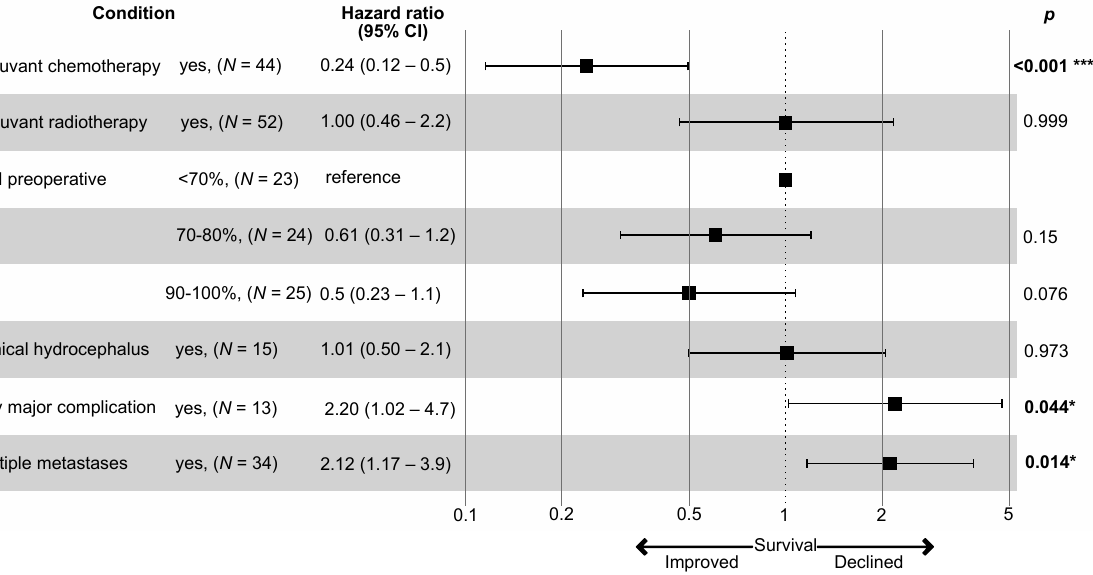
Figure 2. A multivariate Cox regression analyses of the prognostic factors for overall survival. Model metrics: R-squared = 0.397 (max. possible = 0.996), Likelihood ratio test = 36.374 ( p < 0.001). *—significant, ***— highly significant.